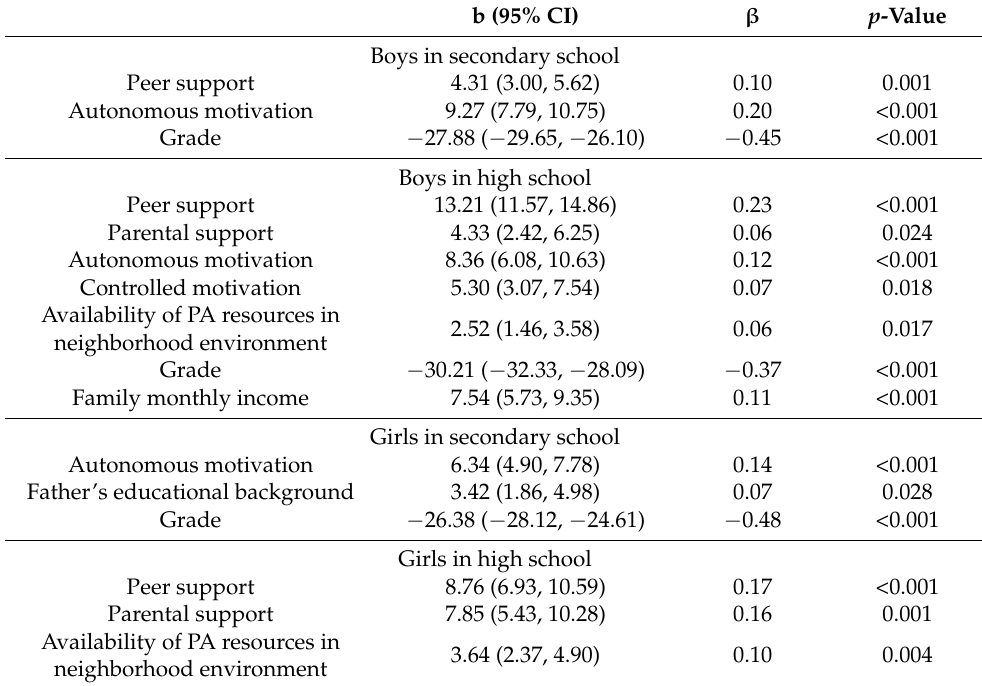
Table A3. Multiple regression analysis for out-of-school MVPA among boys and girls in secondary school and high